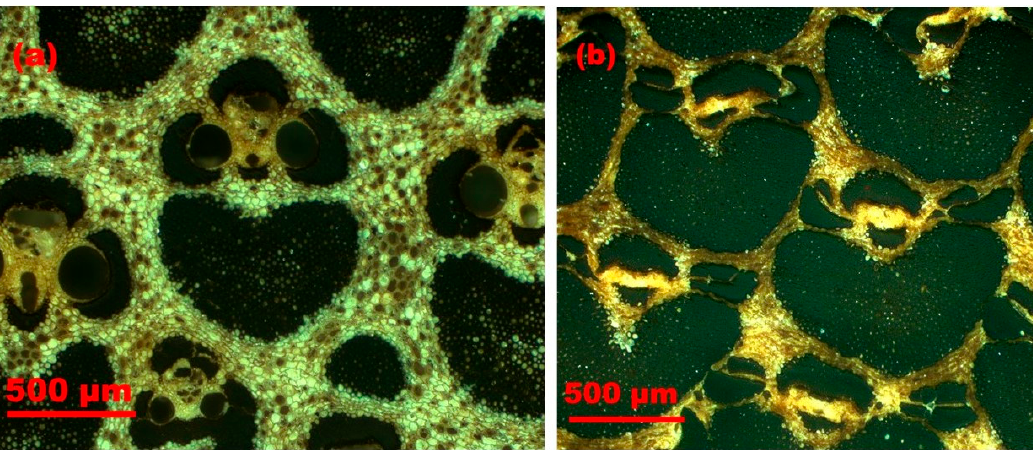
Figure 18. Fiber volume fraction of ( a ) normal bamboo, and ( b ) reformed bamboo (data from [31]).